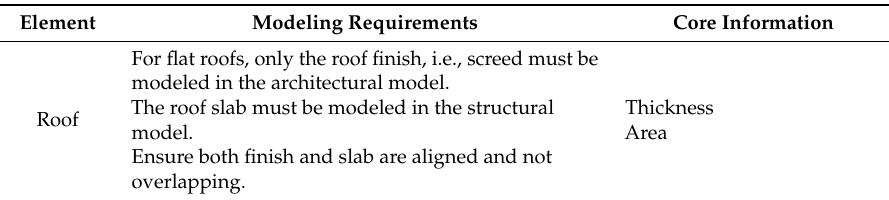
Figure 4. Model elements are mapped with the equation. 4.2.4. Report Generation The Proposed Green Mark Collaboration Environment has a built-in report template. The template will capture all calculated data while restoring its linkage to the building model elements.